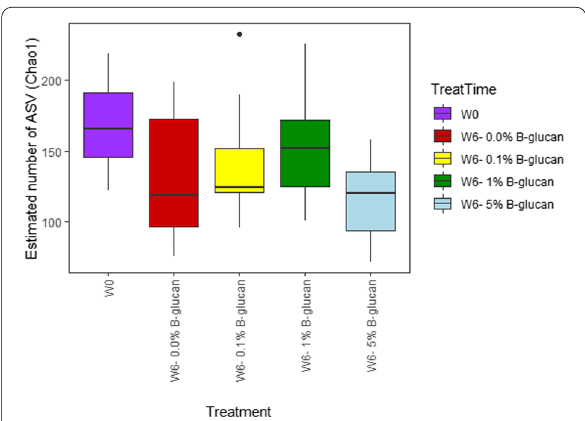
Fig. 1 Alpha diversity measured in Chao1. W0: Diversity for control week 0. W6: Diversity for control week 6. 0.1%: Diversity for microbiota treated with 0.1% β‑glucan. 1.0%: Diversity for microbiota treated with 1.0% β‑glucan. 5.0%: Diversity for microbiota treated with 5.0%